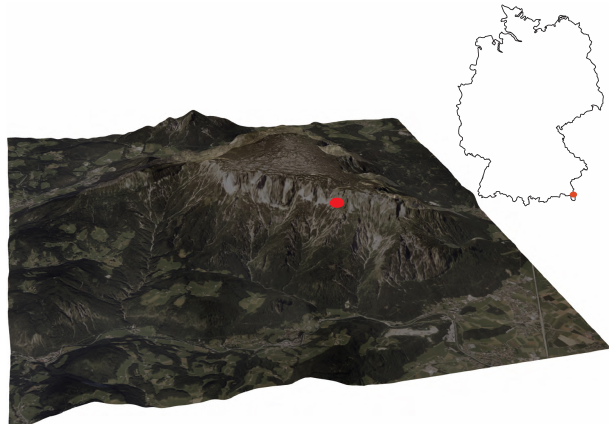
Figure 1. Location of Schellenberger Eishöhle at the foot of the east face of Untersberg. The mountain is viewed from the East, the length of the edges is 11 km (orthophotos: © 2003/2004, Salzburg AG and DI Wenger-Oehn, digital elevation model: Bundesamt für Eich- und Vermessungswesen in Wien). The map inlay shows the location of Untersberg in Germany.